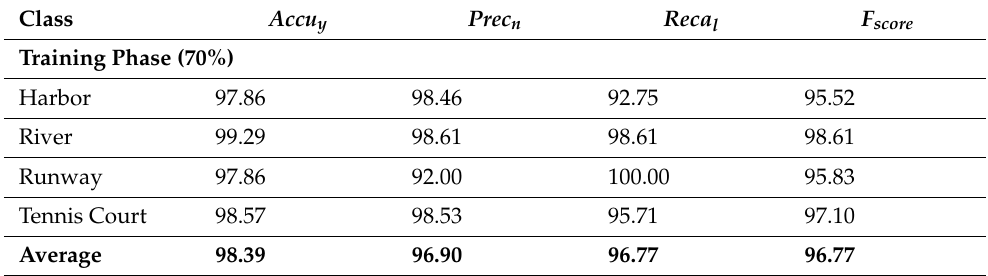
Figure 7. Average outcomes of the BSBE-PPODLC approach on 80:20 on TR/TS datasets. Table 5. Classification results of the proposed BSBE-PPODLC approach on 70:30 on TR/TS